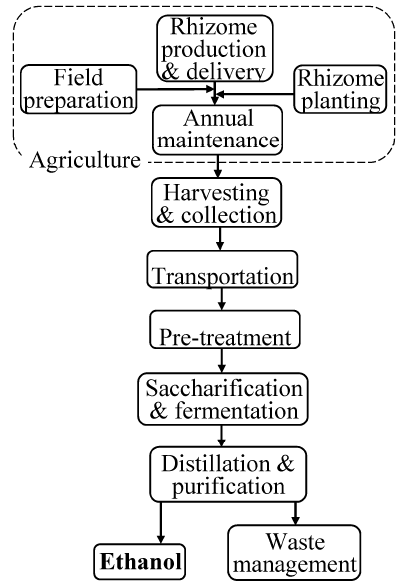
Figure 1. Schematic diagram of the life cycle (LC) of Miscanthus and the system boundary of this